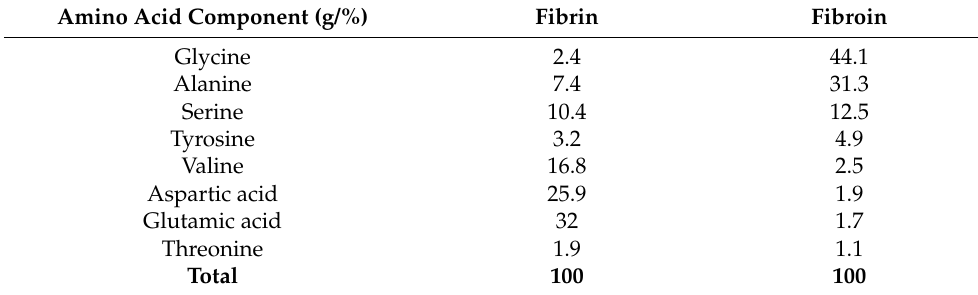
Table 1. Amino acid composition of fibrin and fibroin extract.